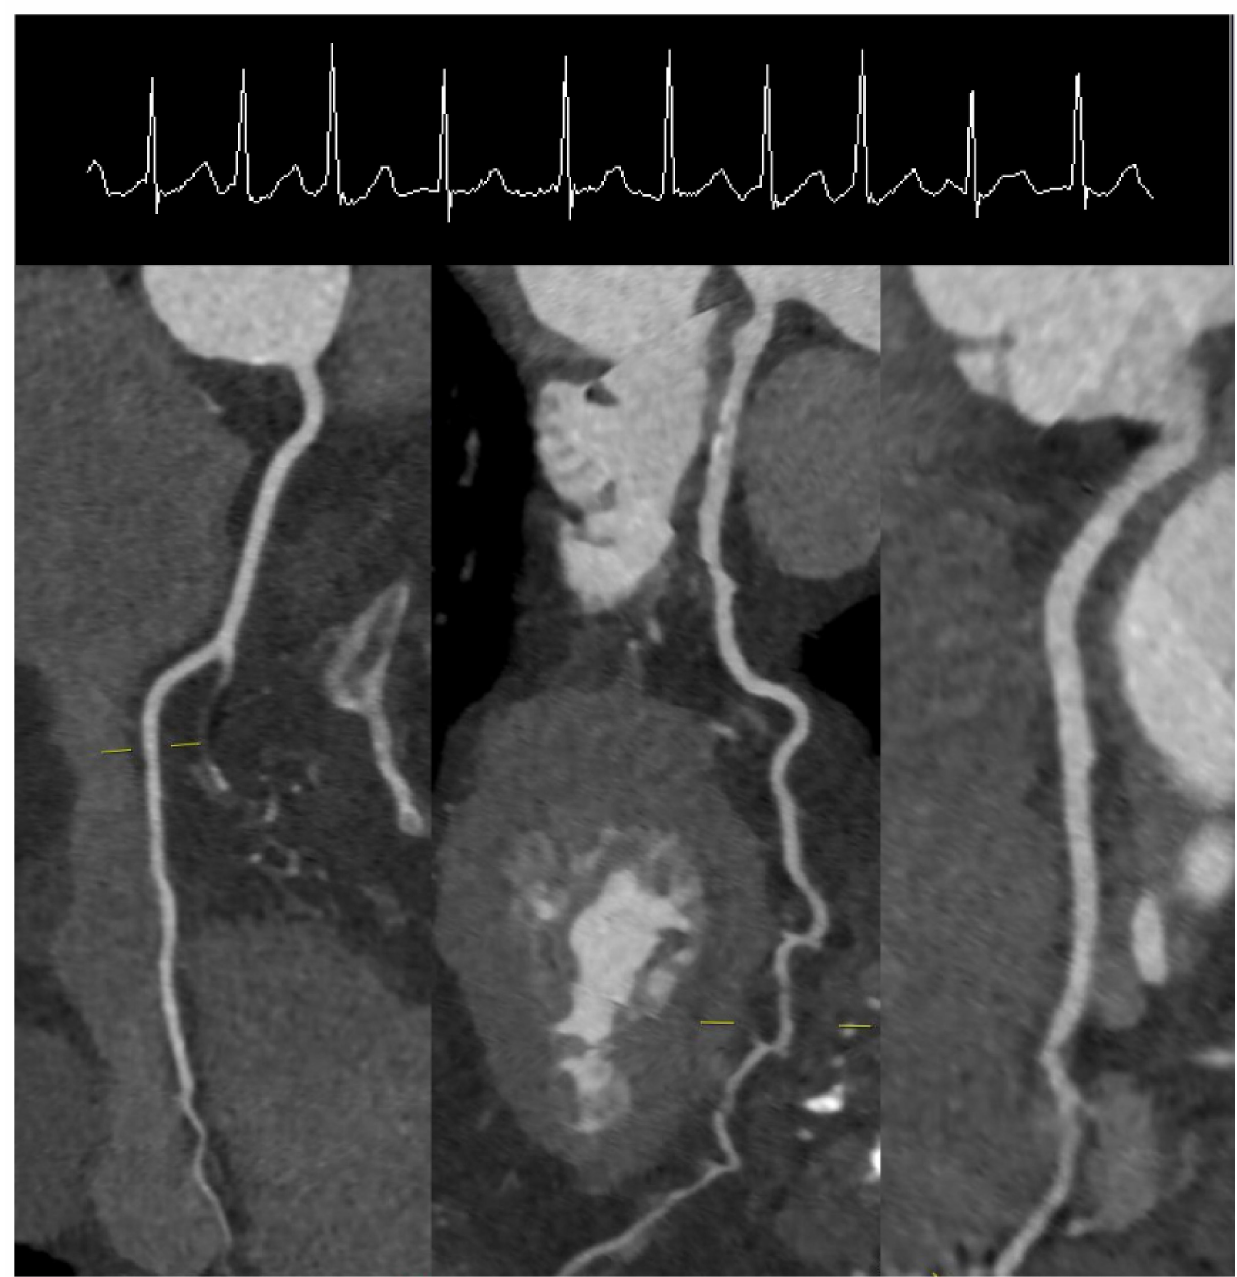
Figure 2. “Step and Shoot” protocol triggering during systole in a patient with atrial fibrillation and a heart rate of